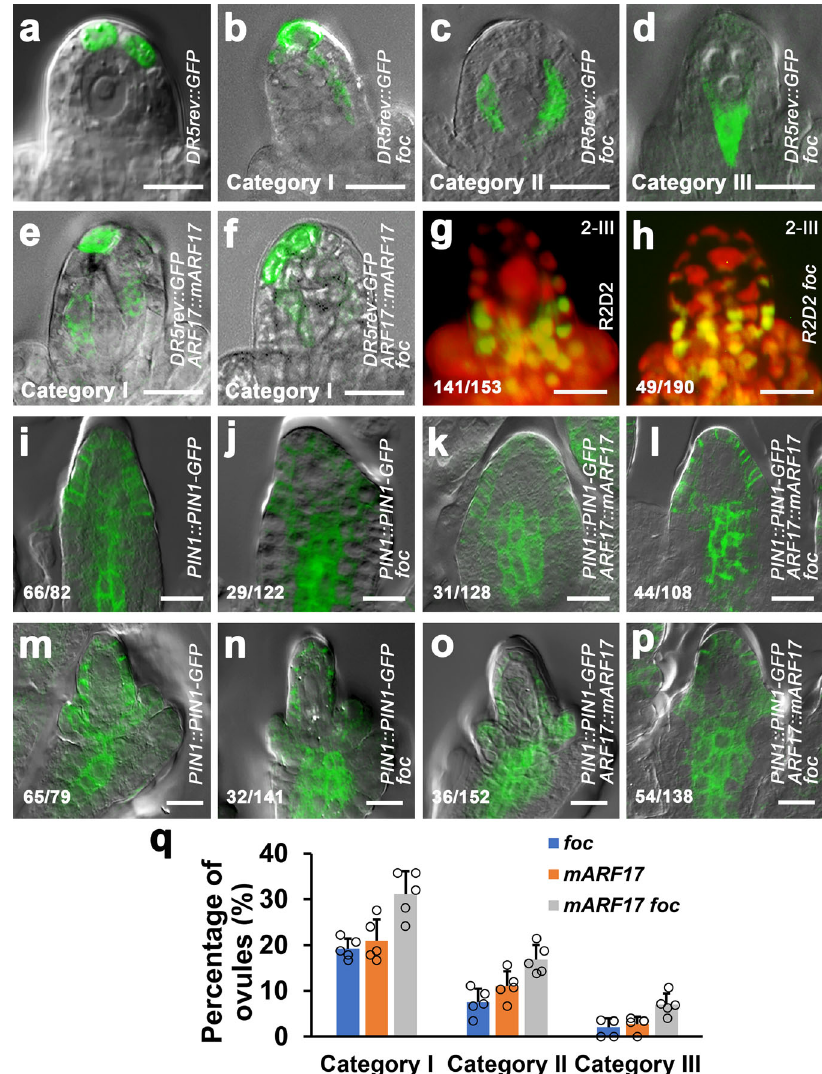
Fig. 6 | miR160 and ARF17 control the local auxin maximum in ovule via de fi ning the PIN1 expression domain. a – f Merged confocal and DIC images of ovules expressing DR5rev::GFP showing auxin maximum distributions. a One auxin maximum at the apex of nucellus of the DR5rev::GFP ovule. DR5rev::GFP foc ovules showing changes of auxin maxima in Category I ( b , expanded apical maxima), CategoryII( c ,centrallyshiftedmaxima),andCategoryIII( d ,basallyshiftedmaxima). Auxin maxima in Category I from DR5rev::GFP pARF17::mARF17 ( e ) and DR5rev::GFP pARF17::mARF17 foc ( f ) ovules. g , h Changes of auxin accumulation in the foc ovule. FluorescenceimagesofovulesexpressingR2D2showingahighlevelofauxin(red)in the nucellus, especially in the MMC of the WT ovule at stage 2-III ( g ) but